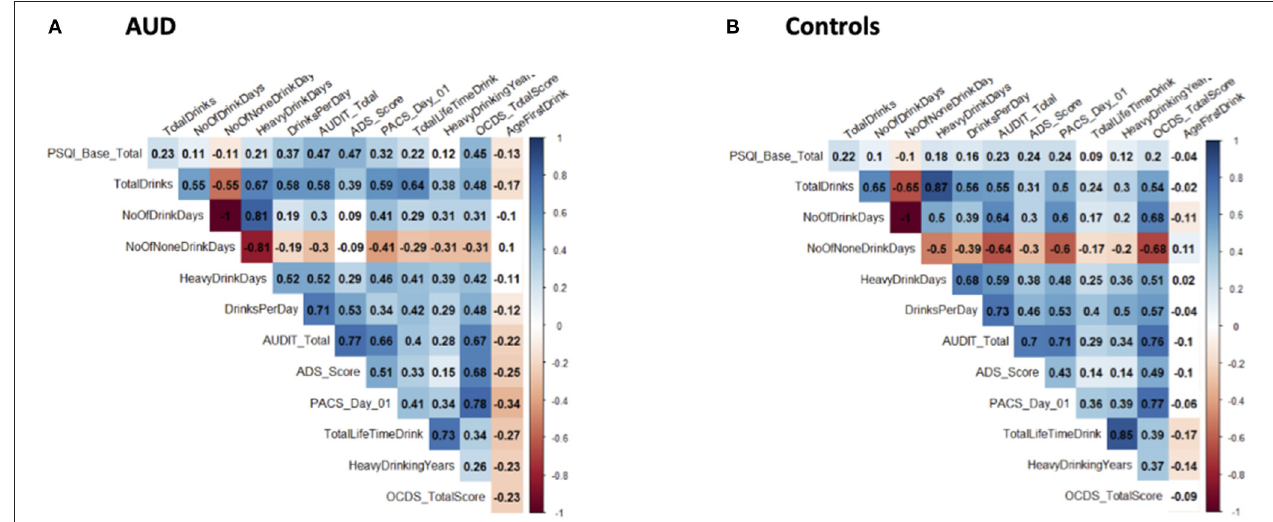
FIGURE 1 | Correlograms for global PSQI score and alcohol-related measures. These correlograms depict the correlation between global PSQI scores and various alcohol-related measures in both AUD (A) and control (B) groups. Significant correlations are indicated by coloration (ranging from red for negative and blue for positive) and non-significant correlations are left uncolored. Correlation coefficients are indicated within each box.